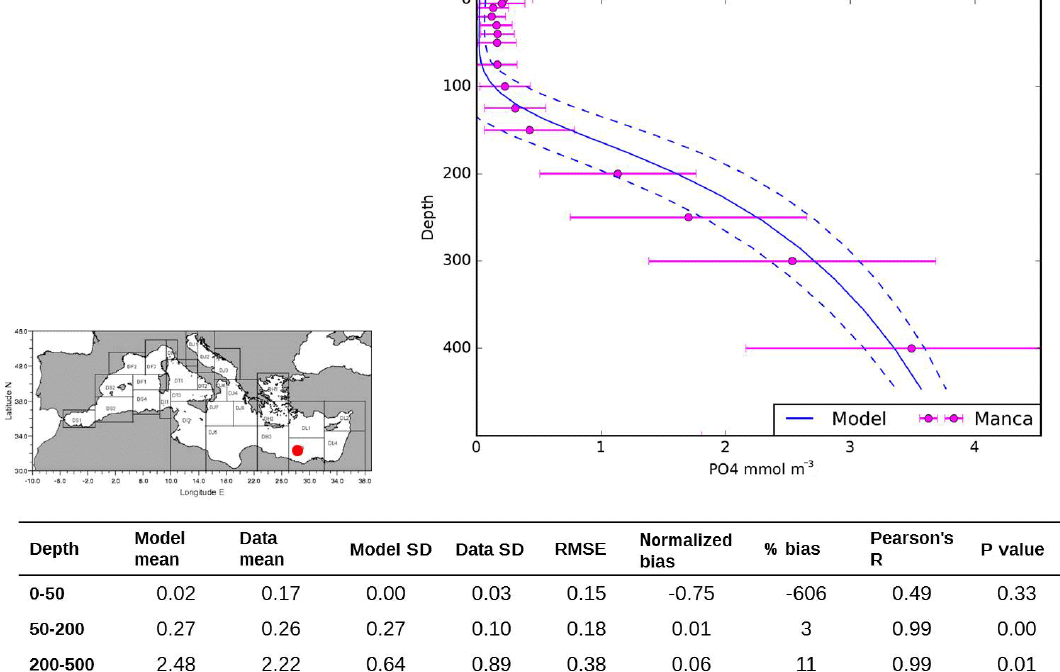
Figure A7. Annually averaged NO 3 vertical profile in the south Levantine sub-basin (see map and Manca et al., 2004) and statistical indicators over different depths. Model values are shown with the blue line (2005 average, Ntot simulation from Richon et al., 2017) and measured values from Manca et al. (2004) are in pink. Horizontal bars and dashed lines indicate the spatial SD of observations and model results respectively.